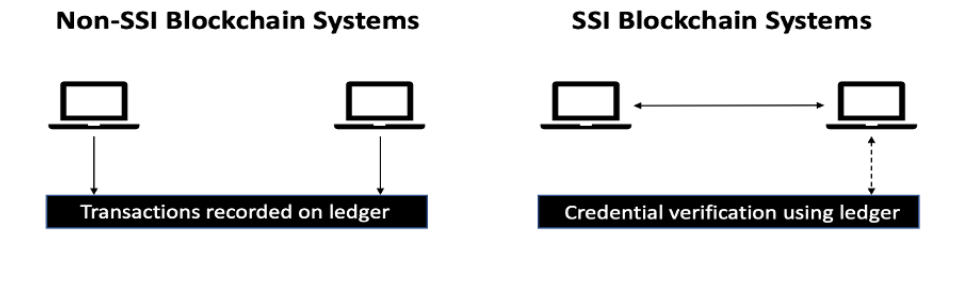
Fig. 1. Comparison of non-SSI and SSI systems showing that transactions are not recorded on ledger in SSI